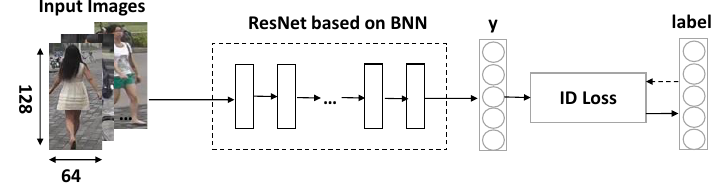
Figure 2. The frame diagram of ReID is realized based on classification. Take the pedestrian image (from dataset Market-1501) as the input; after binary ResNet50 layer network processing, use softmax as the classifier to get a prediction vector y; next, combine with the actual tag label to get the loss for back propagation; finally, get the trained target neural network. BNN, binary neural